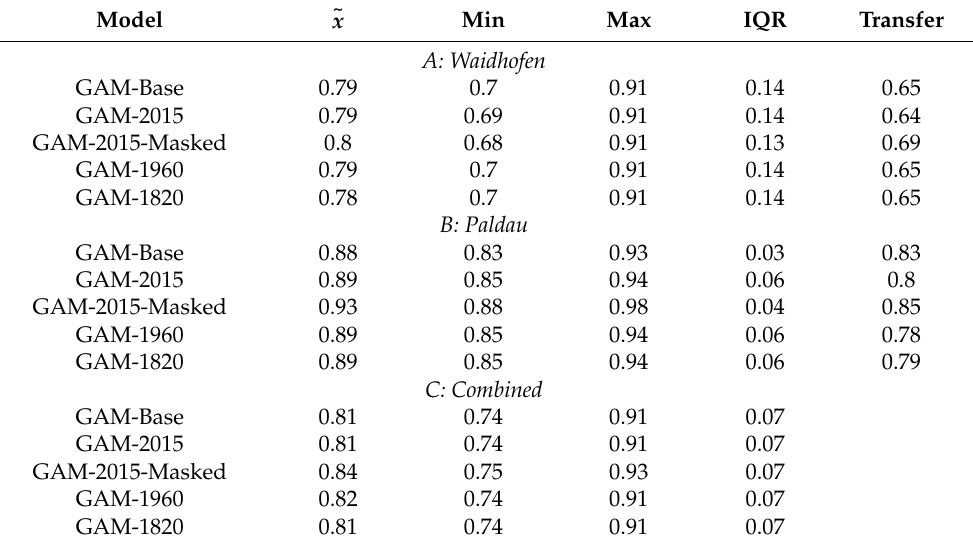
Table A4. Results of the model assessments within the study area with SpCV, and assessment of model transferability between both areas.